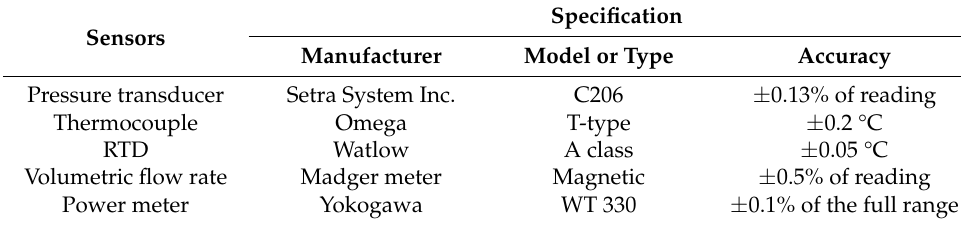
Table 2. Sensor specification.